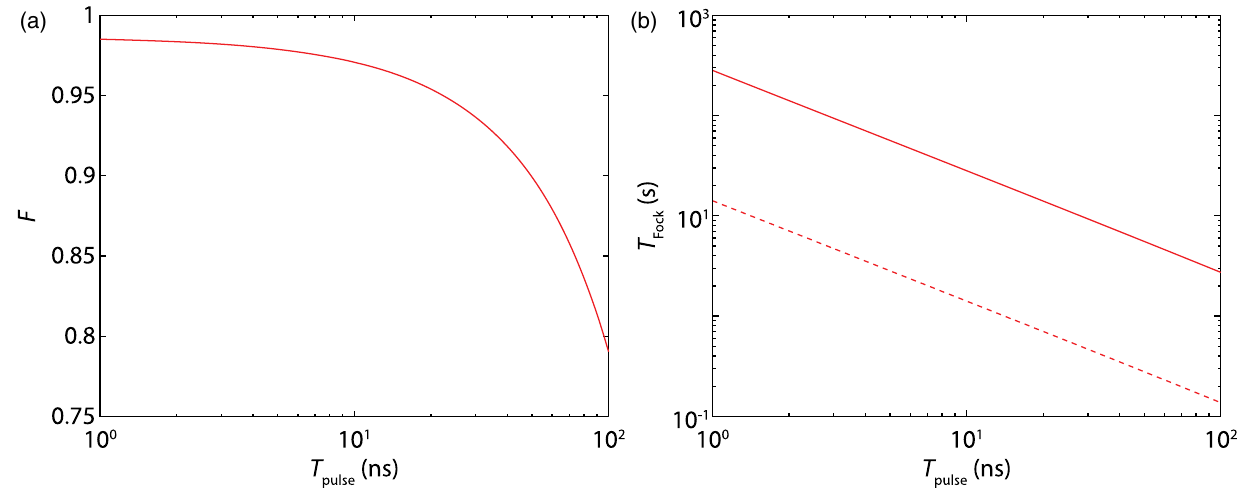
¼ 1 ms). (b) Average (pulse period T pulse per versus pulse width T . The solid line is calculated using the total detection efficiency Fock pulse